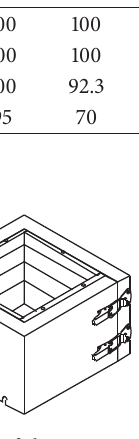
Figure 4: Schematic diagram of the integrated thermal insulating layers and the test